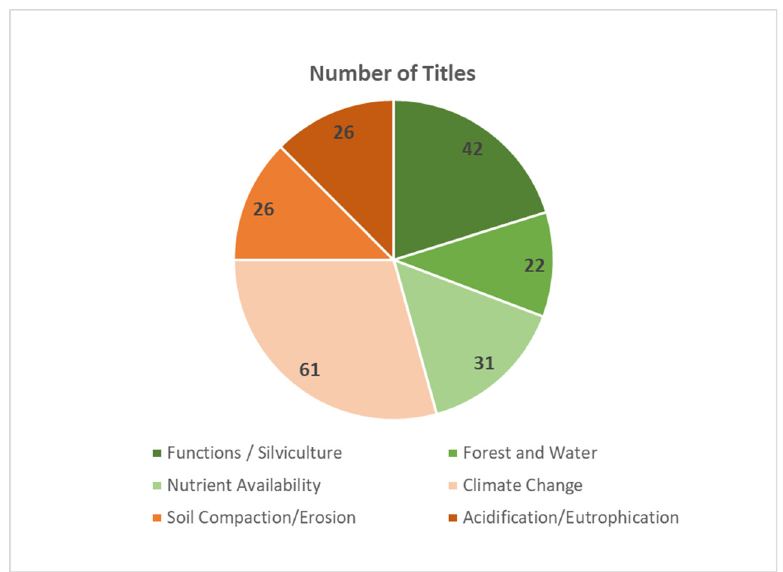
Figure 1. Number of articles in six thematic fields on forest soils and their functions, threats and management. Green colors show thematic fields focusing mainly on the specific functionality of forest soils; reddish colors indicate fields focused on threats to forest soil functions and measures to counteract them.